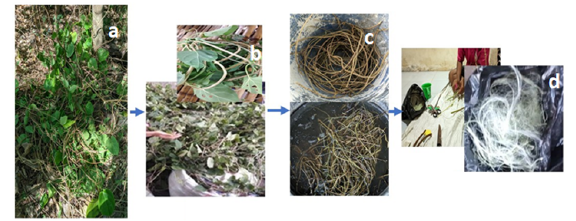
Fig. 3. PFs (a) raw, (b) KOH treated dan (c) NaOH Fig. 1. Paederia foetida , PF, (a) plant, (b) selection of PF stems, (c) Soaking PF in water, (d) Extracting fiber from PF stems.